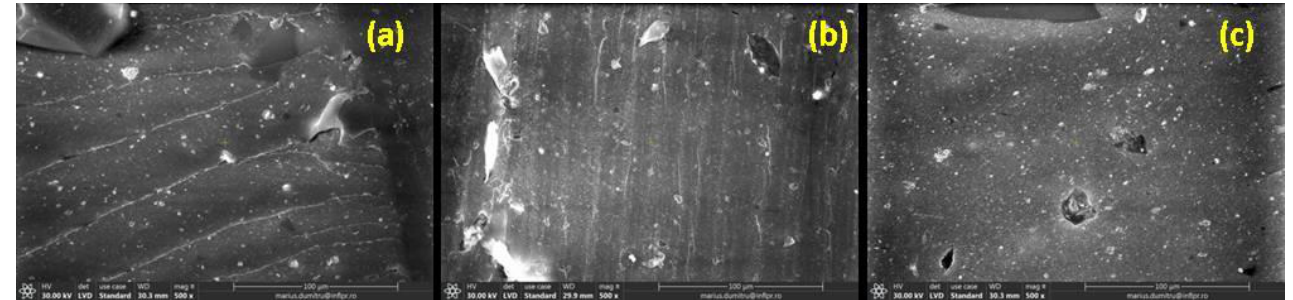
Figure 7. SEM micrographs of non-irradiated NR-U sample ( a ) and irradiated at 150 kGy ( b ) and 450 kGy ( c ) (magnification of 500).